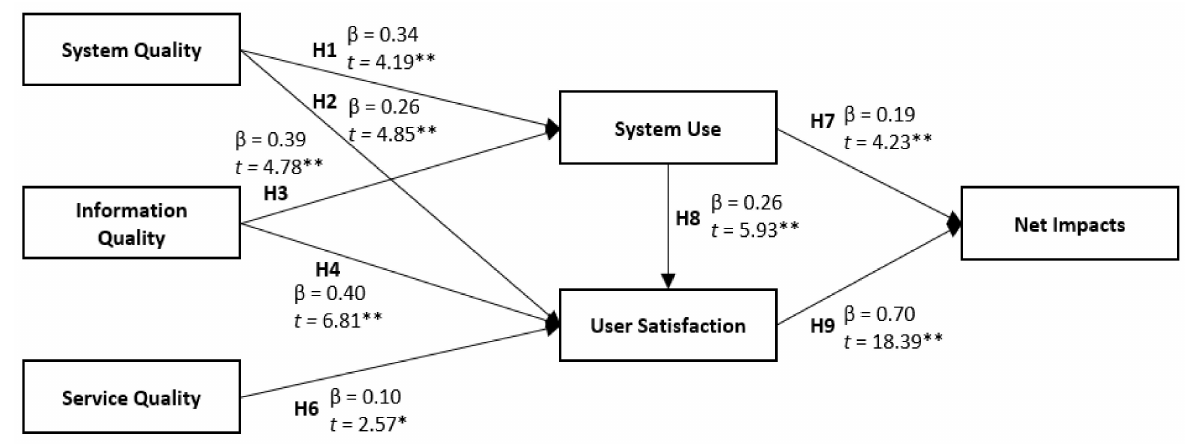
Figure 3. The revised CRISS success model; * p < 0.05, ** p <